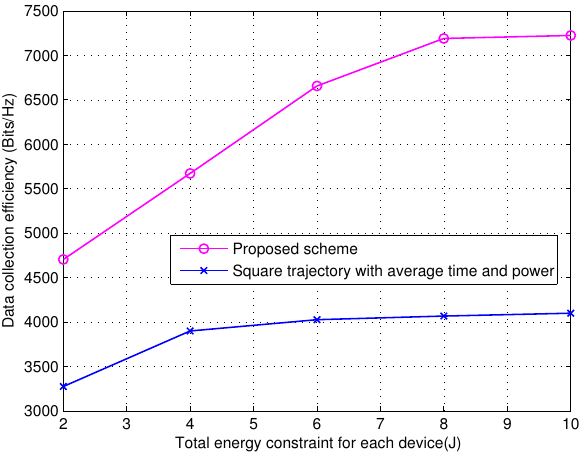
Figure 5. Comparison of data collection efficiency versus total energy constraint of each device for proposed scheme and the square trajectory with average time and